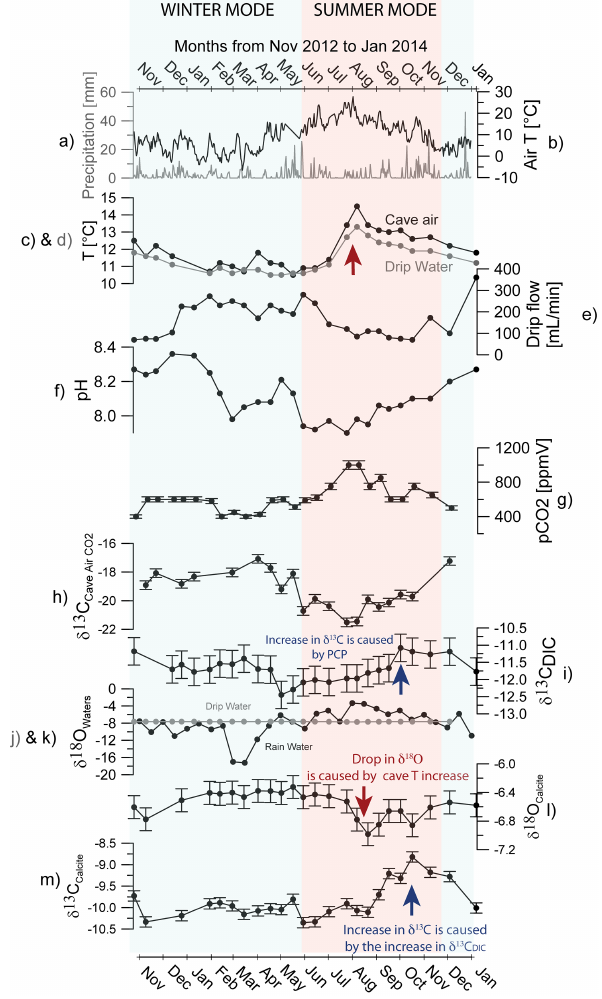
Figure 2. Precipitation intensities (a) and air temperatures (b) are measured at the Han-sur-Lesse station of the Royal Meteorological Institute. All measured cave parameters – the cave air and drip wa- ter temperature (c and d) , drip flow (e) , drip water pH (f) , cave air p CO 2 (g) , δ 13 C CAVE AIR CO2 (h) , δ 13 C DIC (i) , δ 18 O RAINWATER (j) , δ 18 O DRIP WATER (k) , and the δ 18 O (l) and δ 13 C (m) of freshly deposited calcite on glass slabs – were measured during the cave- monitoring campaign from November 2012 through January 2014. Cave-monitoring results show that the cave conditions vary season- ally between a “summer mode” (red shadow) lasting from June to December and a “winter mode” (blue shadow) lasting from Decem- ber to June. The water δ 18 O values (j and k) are reported in per mill VSMOW. δ 13 C CAVE AIR CO2 (h) , δ 13 C DIC (i) , and δ 13 C and δ 18 O of freshly deposited calcite on the glass slabs (l and m) are reported in per mill VPDB.